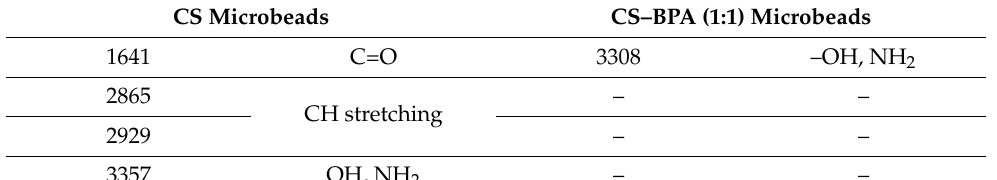
Figure 6. The ATR-FTIR analysis for CS and CS–BPA (1:1) microbeads. Table 2. Peak data for CS and CS–BPA (1:1) microbeads.